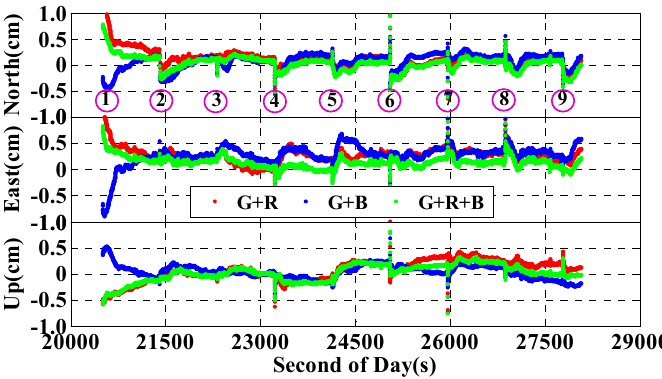
Figure 15. Position offsets time series of GNSS outage simulation test of the PPP/INS tightly coupled integration using the HVCE based adaptive Kalman filter with the multi-GNSS (G + R, G + B, and G + R + B) data.